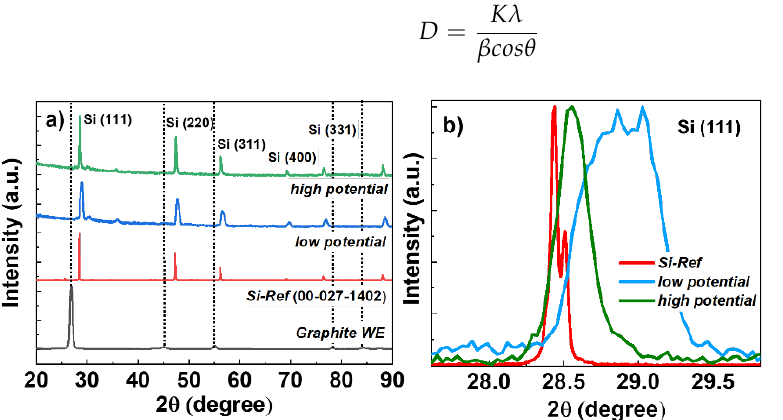
Figure 2. ( a ) XRD patterns, taken at θ –2 θ mode, of the Si powders from the samples electrodeposited on graphite substrates with low and high reduction potentials vs. Mo-RE. The intensity of the XRD of the graphite rod (WE) has been reduced to a factor of 1/10. ( b ) Normalized XRD pattern of (111) peaks.